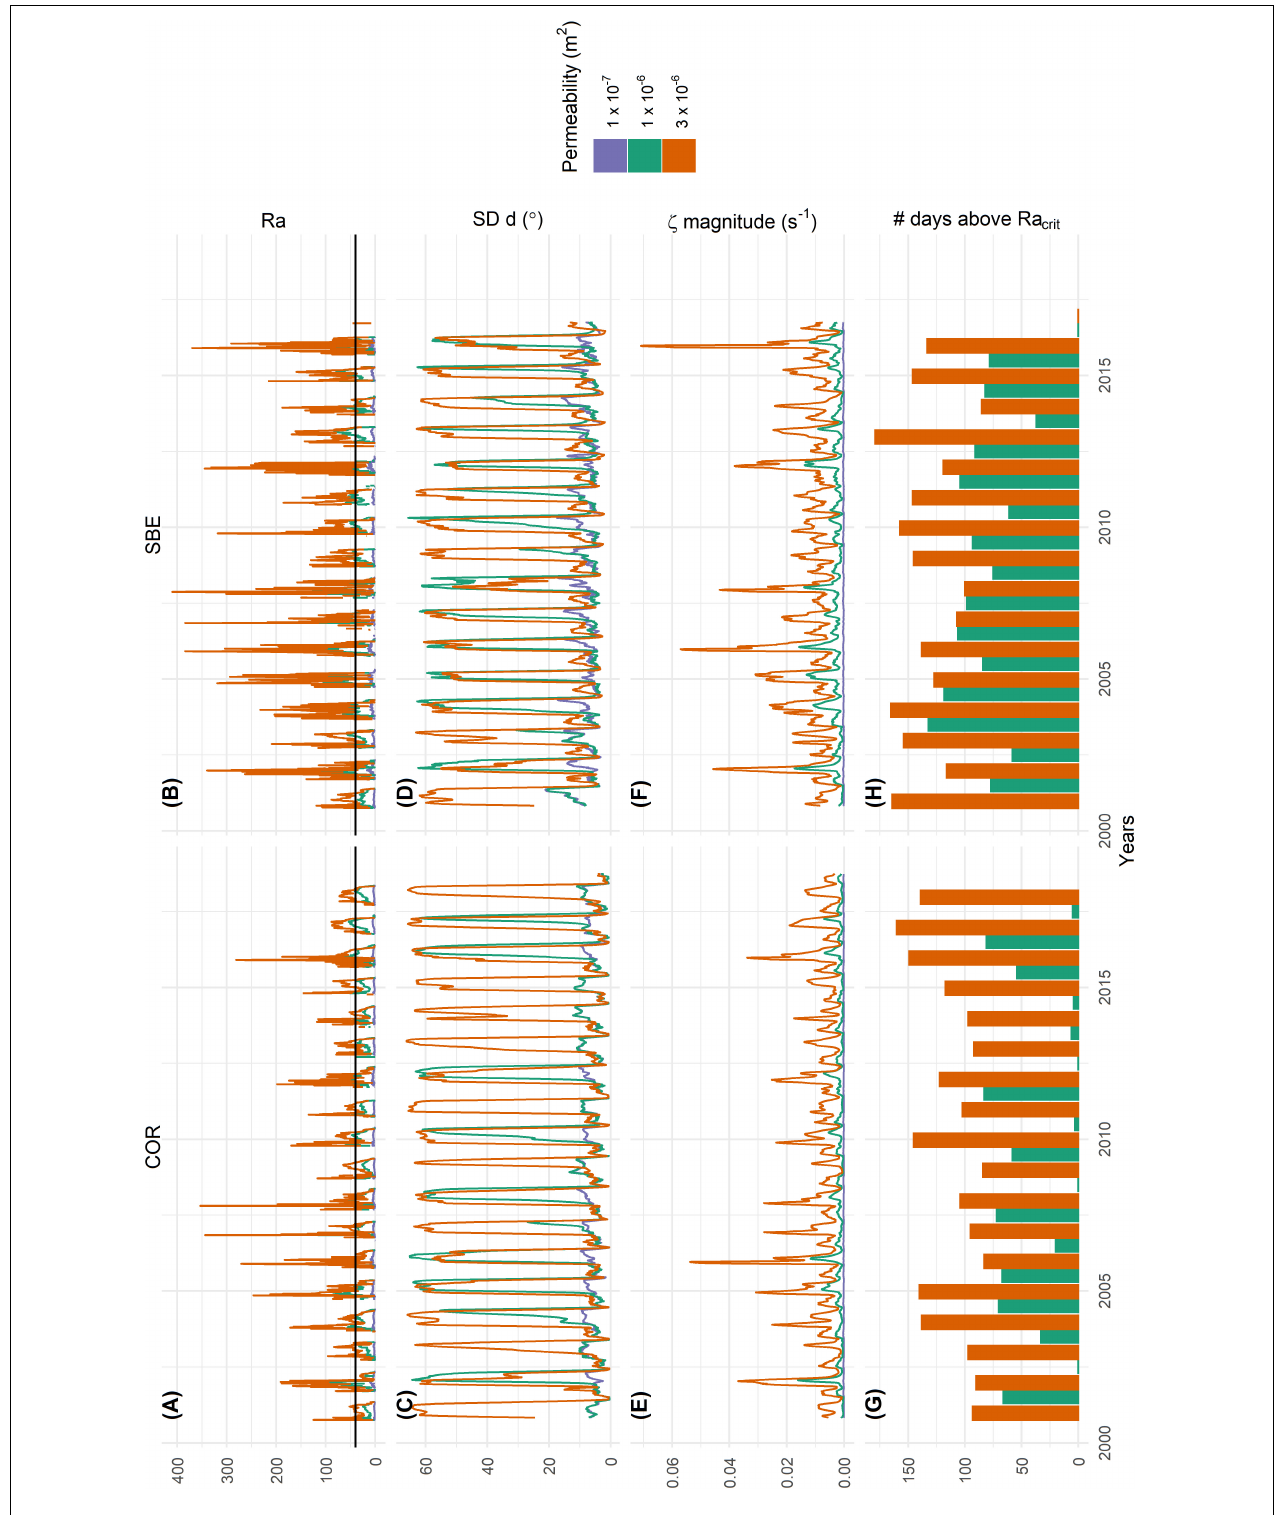
FIGURE 7 | (A,B) Rayleigh number Ra with Ra crit in black, (C,D) monthly rolling mean of the standard deviation of the airflow direction d , (E,F) monthly rolling mean of the magnitude of the vorticity ζ and (G,E) the number of days above a critical Rayleigh number within the hydrological year for COR (A,C,E,G) and SBE (B,D,F,H) for three different permeability values, represented by different colors. The magnitude of ζ and the standard deviation of d are calculated over the airflow vector field shown in Figure 6 , respectively Figure 1 .